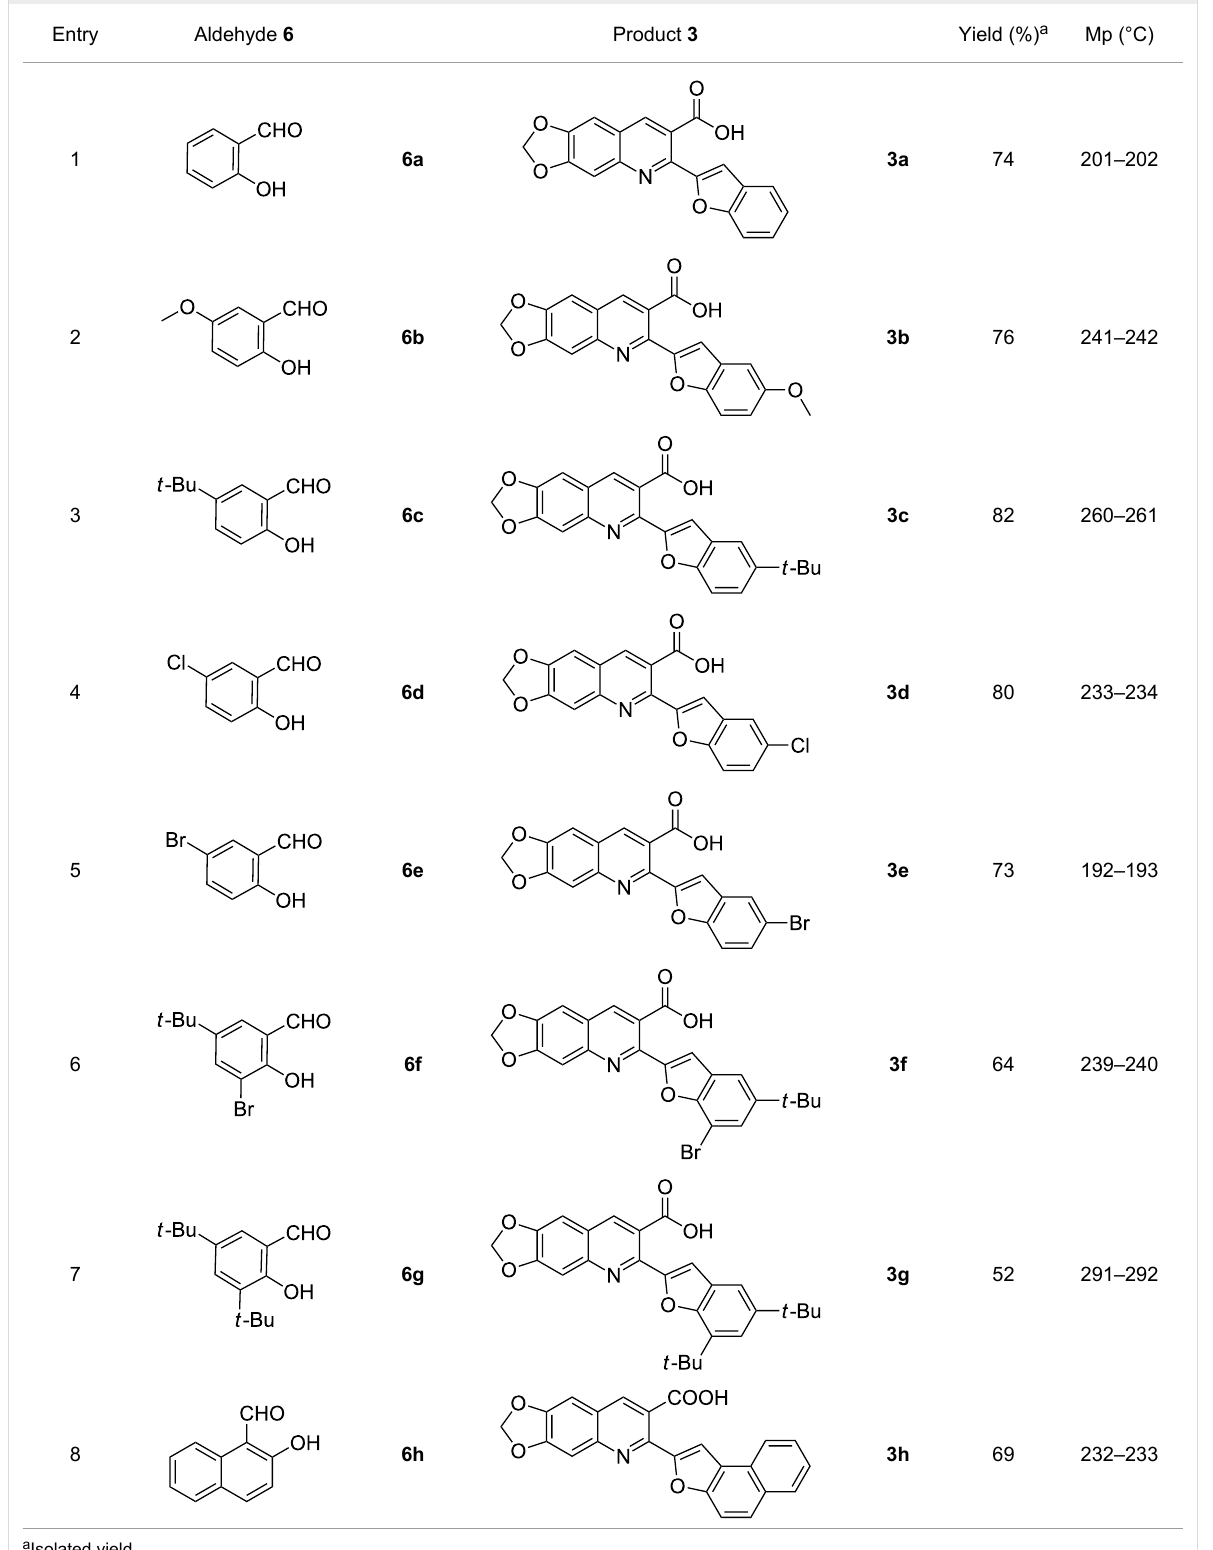
Table 1: Synthesis of 2-benzofuranyl-6,7-methylenedioxyquinoline-3-carboxylic acids 3a – h